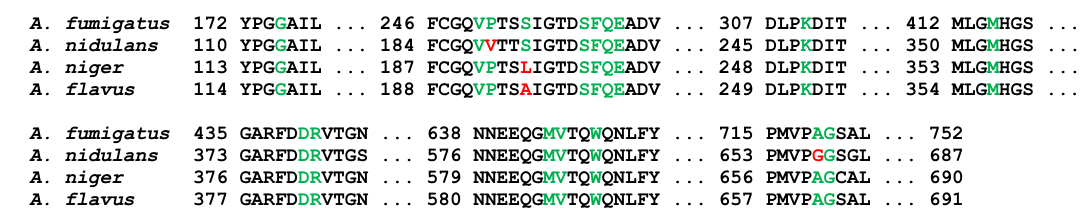
A. fumigatus 172 YPGGAIL ... 246 FCGQVPTSSIGTDSFQEADV ... 307 DLPKDIT ... 412 MLGMHGS ... A. nidulans